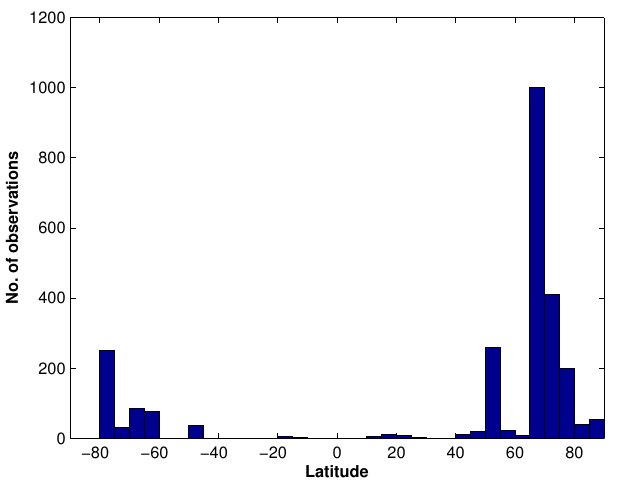
Figure 3. Number of Phaeocystis observations as a function of lat- Fig. 3. Number of Phaeocystis observations as a function of latitude for the period of 1950–2009. Most itude for the period of 1950–2009. Most observations are located in observations are located in the temperate and high latitudes of the Northern Hemisphere. the temperate and high latitudes of the Northern Hemisphere.